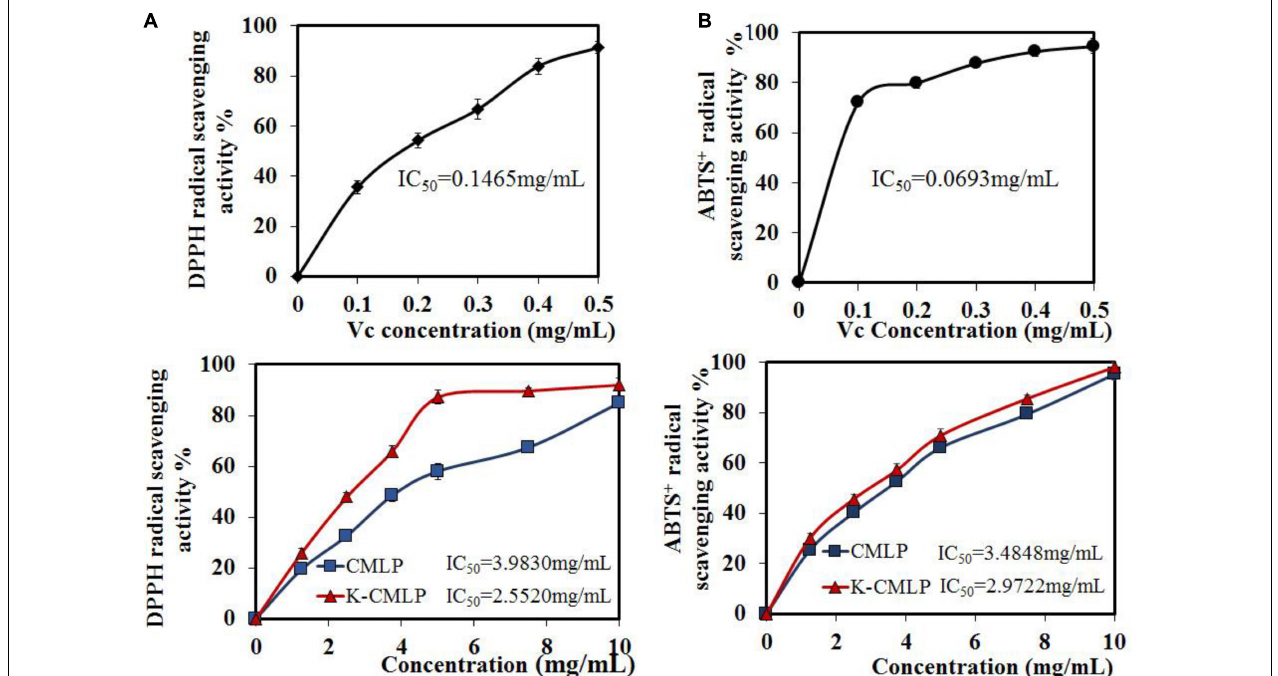
FIGURE 7 | Antioxidant activities of CMLP and K-CMLP: DPPH · radical-scavenging activity (A) ; ABTS + · radical-scavenging activity (B) . Values are the mean ± SD of three replicates.